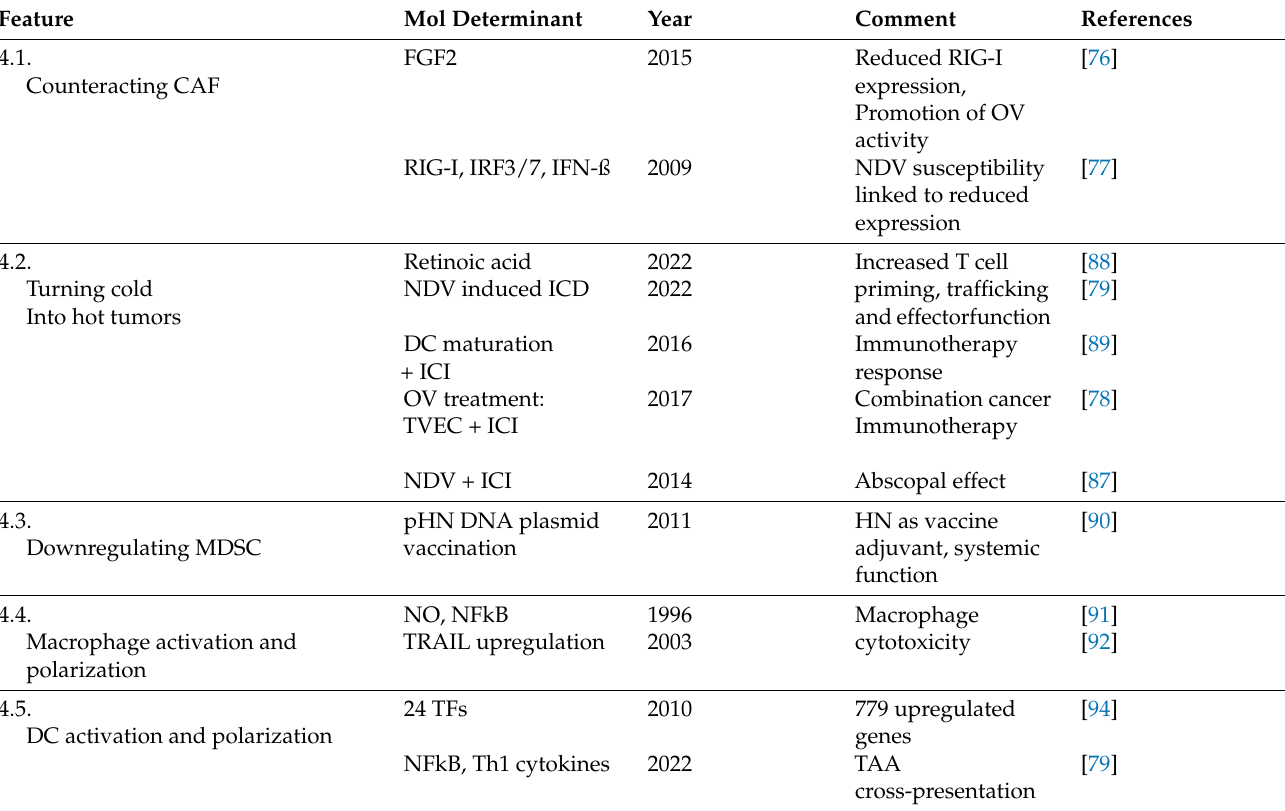
Table 3. Counteracting immunosuppression via oncolytic NDV or cellular